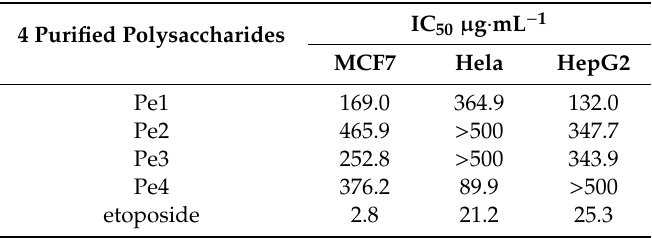
Table 5. The IC 50 values of the antitumor activity of the four purified polysaccharides against the three types of cancer